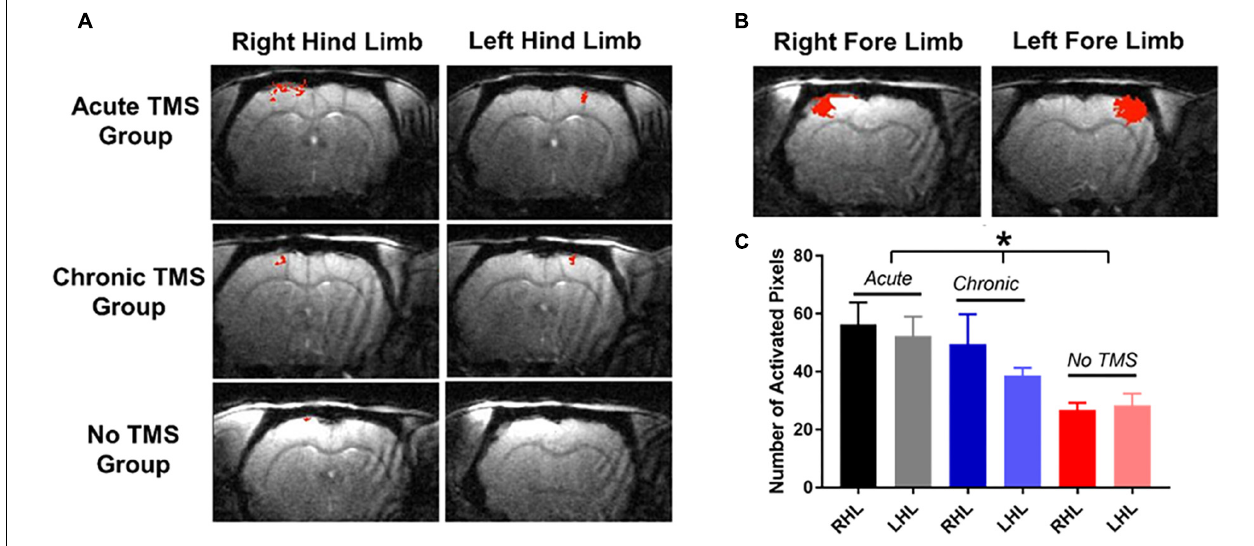
FIGURE 4 | (A) fMRI measurements: were obtained 10 weeks after SCI. Individual fMRI cross-correlation statistical maps demonstrate increases in fMRI responses (in red) to contralateral stimulation of hindlimbs in the acute-TMS ( n = 7) and chronic-TMS ( n = 5) treatment groups, but not in the no- TMS group ( n = 5). (B) Show sensory responses to stimulation of forepaws. (C) Data plots shows that the acute-TMS group demonstrated the greatest sensory responses to right and left hindlimb (LHL) stimulation compared to chronic-TMS and no-TMS groups. Statistical significance was determined by one-way ANOVA [ F (5,28) = 3.554, p =